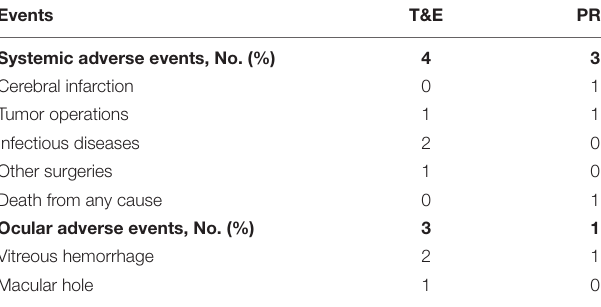
TABLE 4 | Systemic and ocular adverse events of interest through 2 years of